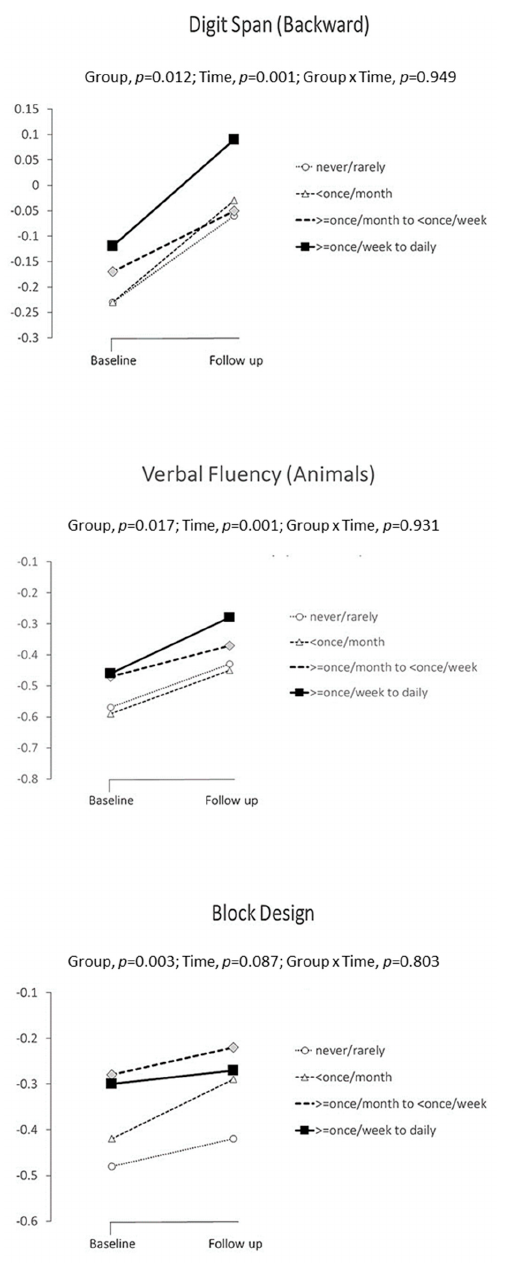
(Table 2) for MMSE, Digit Span-Backward, Verbal Fluency-Animals, Trail-Making Tests A and B and Block Design. In mixed model analyses, (Table 3 and Figure 1) controlling for known or potential confounding risk factors, significant between-group differences were shown for Digit Span (Backward), Verbal Fluency (Animals) and Block Design. Pair- wise comparisons showed that compared to “never or rarely” consumption, “very often” and “often” consumptions were associated with significantly higher levels of Digit Span- Backward; “very often” was associated with significantly higher performance on Verbal Fluency-Animals, and “occasional”, “often” and “very often” consumptions were associ- ated with significantly higher performance on Block Design. The estimated Cohen’s d for significantly enhanced neurocognitive functions ranged from 0.130 (Digit Span-Backward) to 0.186 (Block Design).